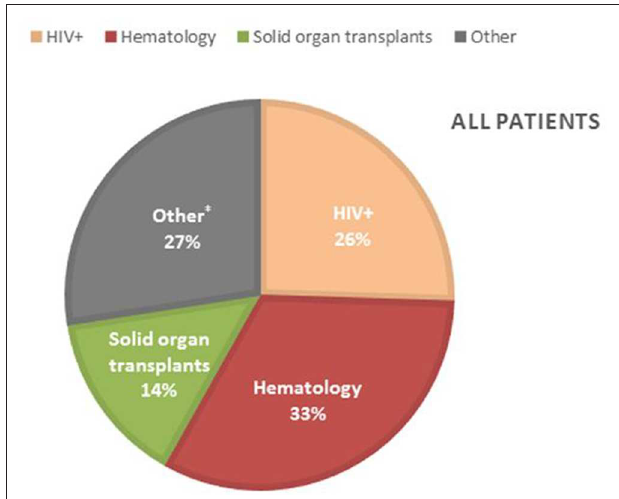
FIGURE 3 | Incidence of PCP in the different PCP patient groups. *Other patients; lung diseases (11), patients with malignancy other than hematology (11), (metastatic) brain tumors (6), dermatology patients (4), auto-immune diseases (4), rheumatoid arthritis (2), hyperthyroidism (1), mental health patient (1), unknown